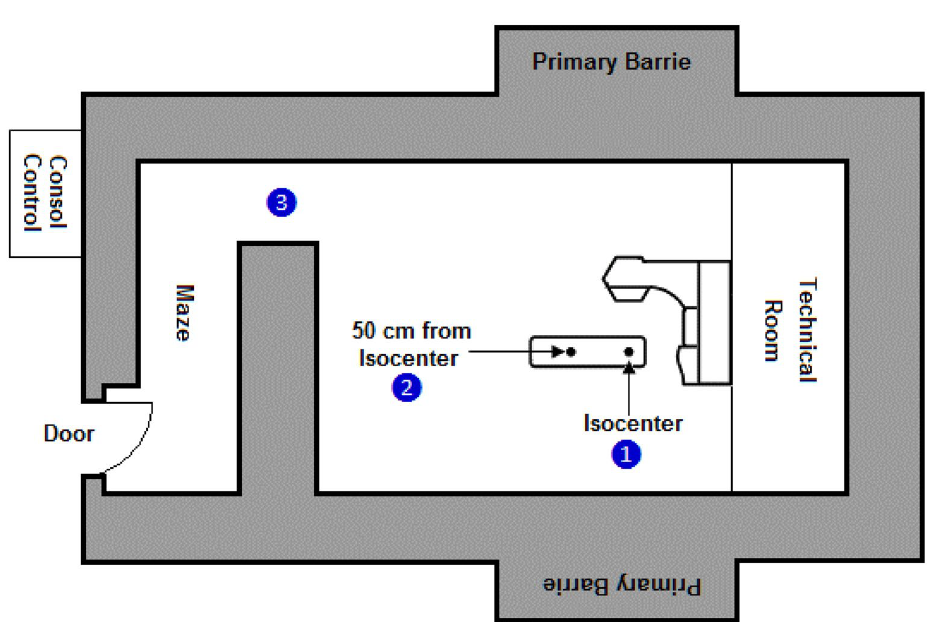
Figure 3. Three PN spectrometry measurement locations shown inside the radiotherapy treatment bunker of the medical accelerator (darker shaded regions are high density